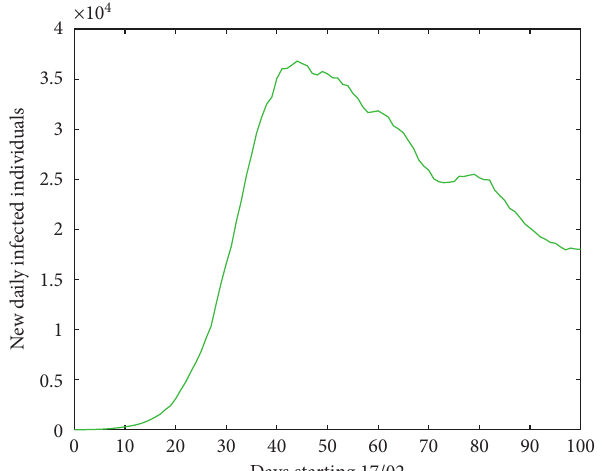
Figure 3: Number of new daily infected individuals in Europe, starting 17 February 2020 and computing the first 100 days with the mean of the seven previous days.